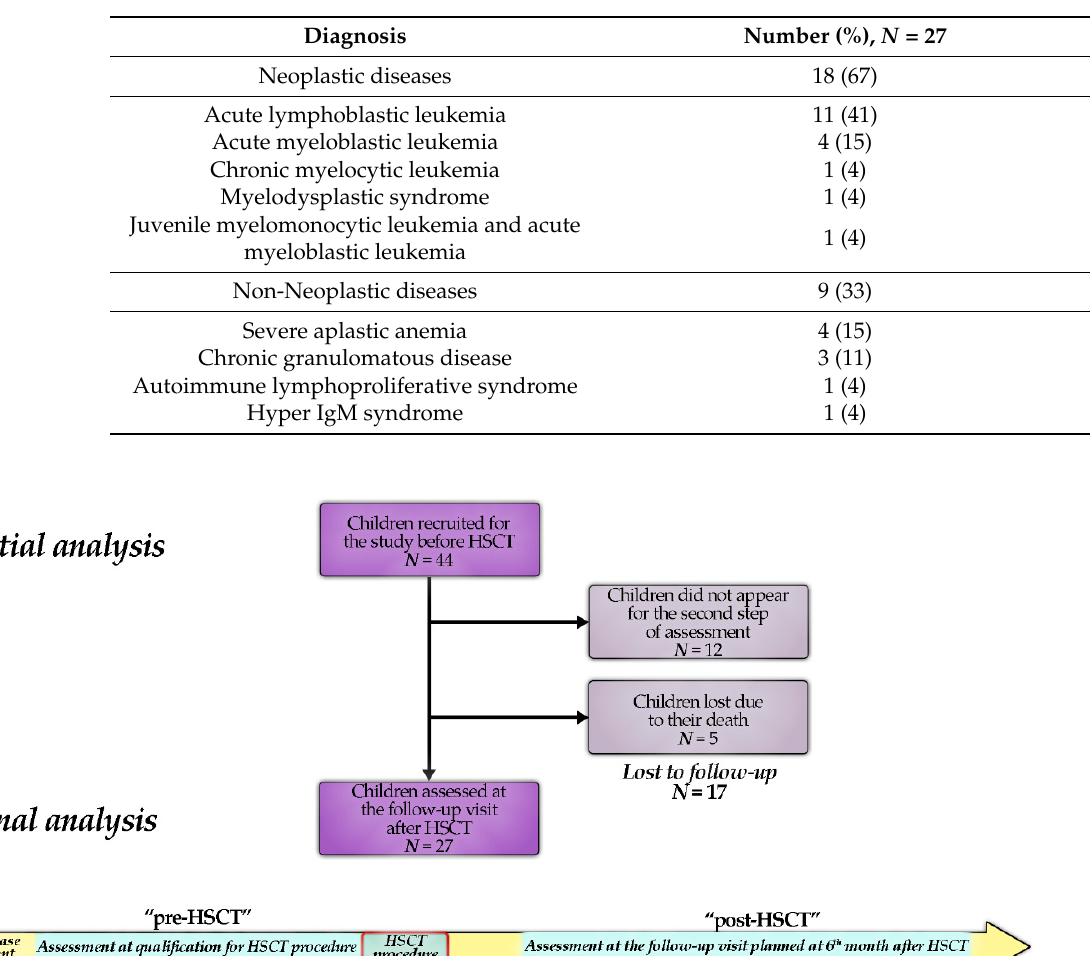
Table 1. Indications for allogeneic HSCT.